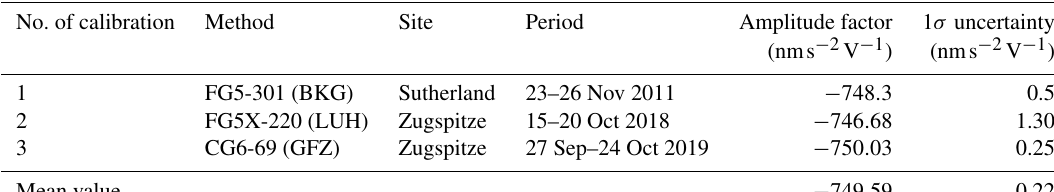
Table 1. Amplitude factors of the OSG 052 estimated from three